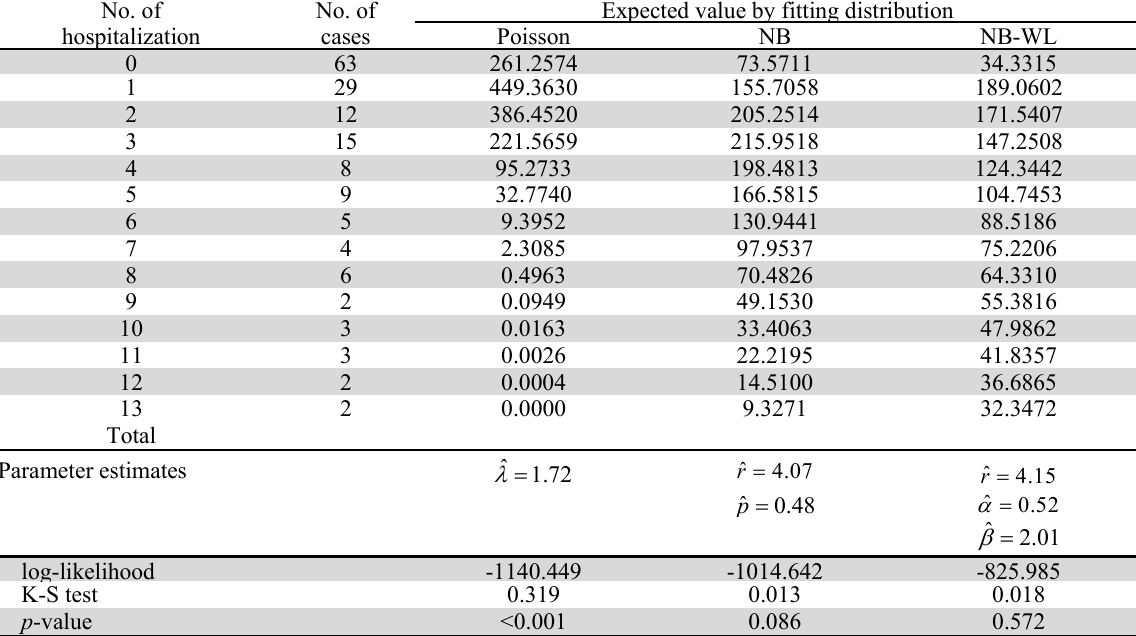
Observed and expected frequencies for number of hospitalized patients with diabetes No. of No.